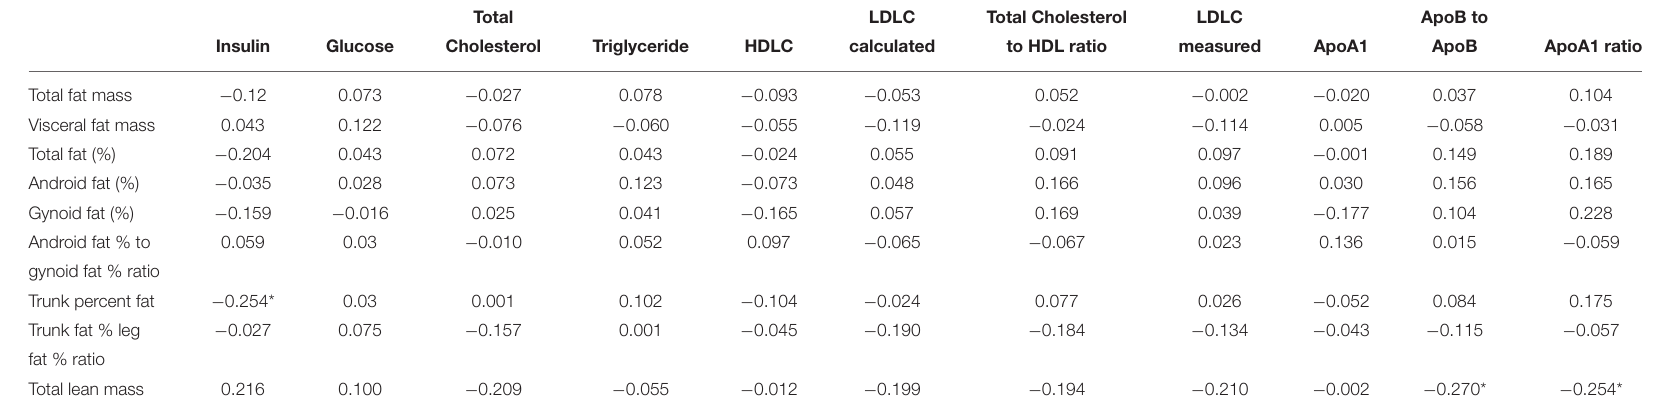
TABLE 7 | Spearman’s correlations between changes in body composition measures due to intervention with changes in blood markers of cardiometabolic health in men ( N = 61, one subject was excluded from analysis as lipid variables were too extreme).